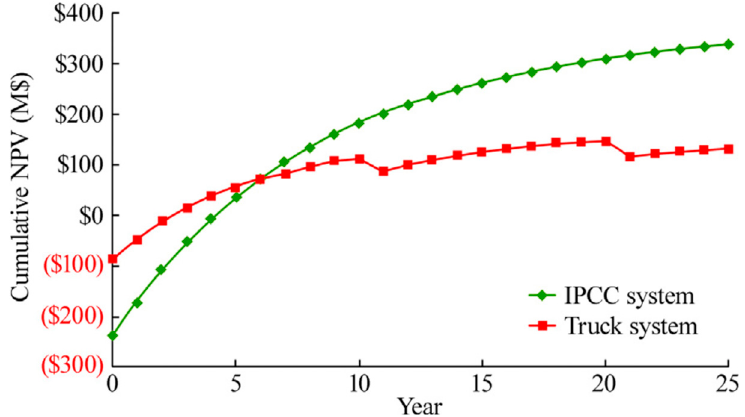
Figure 8. The cumulative net present value comparison of TS and IPCC systems [11].